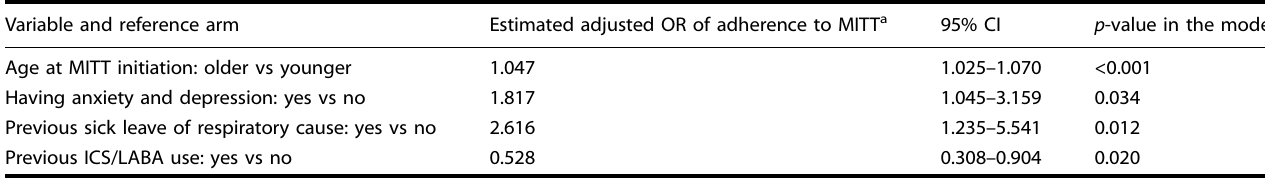
Table 4. Independent factors associated with adherence to MITT determined by the logistic regression model. Variable and reference